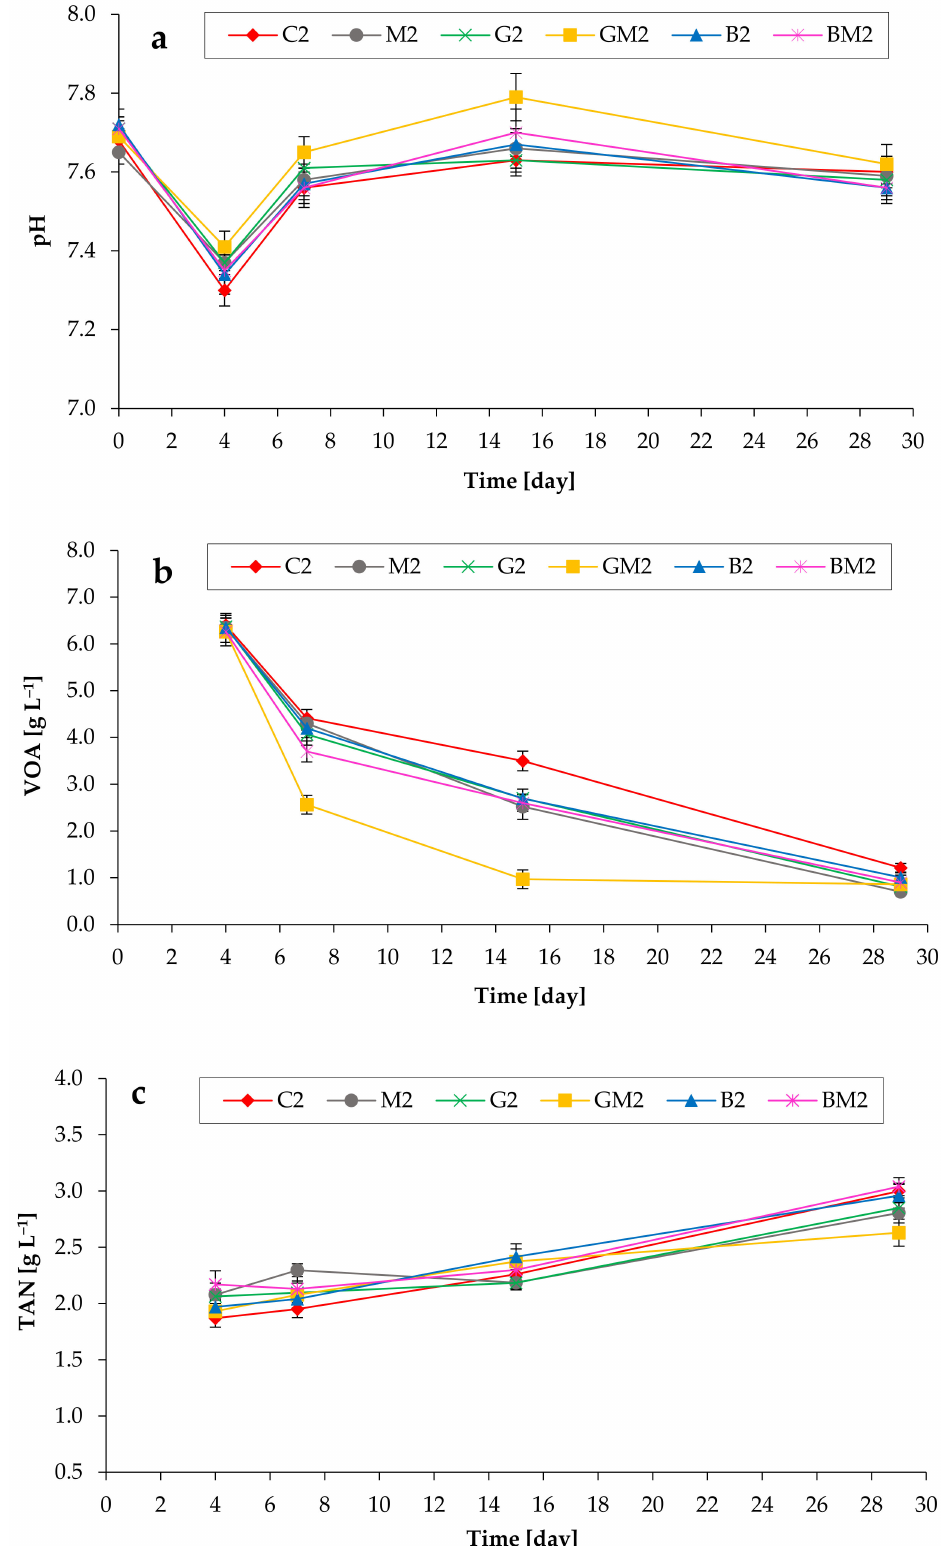
Figure 4. Impact of various additives addition on pH changes ( a ), VOA concentrations ( b ), and TAN concentrations ( c ) during anaerobic digestion of chicken manure (TS of